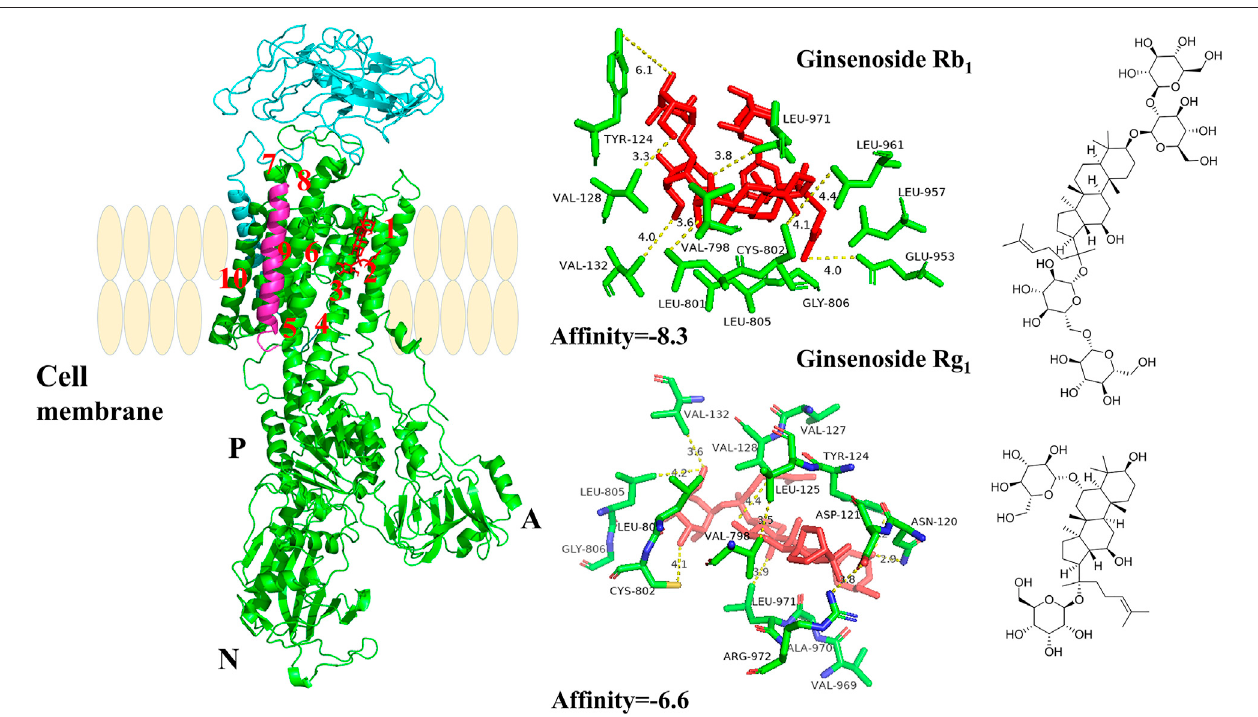
FIGURE 6 | The crystal structure of the high-af fi nity Na + /K + -ATPase α 1 subunit – ginsenoside Rb1 or – ginsenoside Rg1 complex. Ginsenoside Rb1 or ginsenoside Rg1 are depicted in red, and the chains of Na+/K+-ATPase α / β / γ subunits are represented by green, cyan blue, and magenta, respectively. Data deposition: the crystallography, atomic coordinates, and structure factors have been deposited in the Protein Data Bank (www.pdb.org (PDB ID code